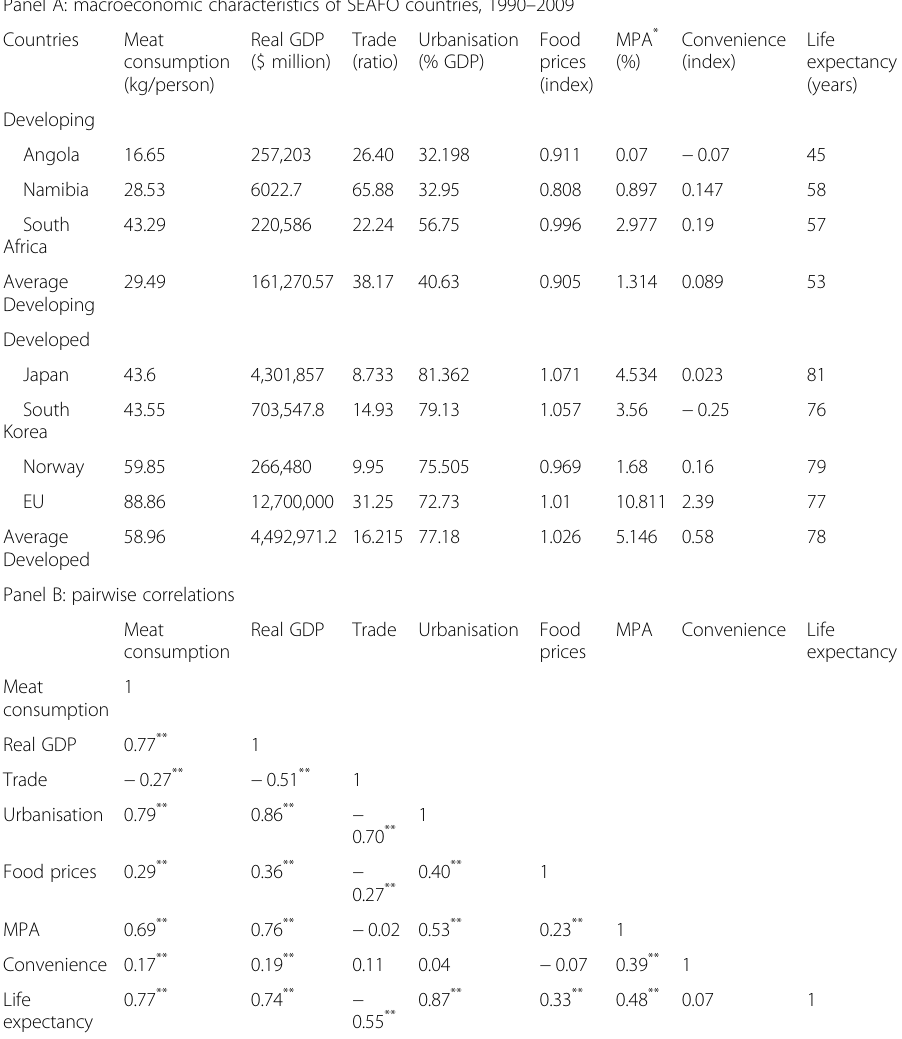
Table 1 SEAFO countries descriptive statistics Panel A: macroeconomic characteristics of SEAFO countries, 1990 –